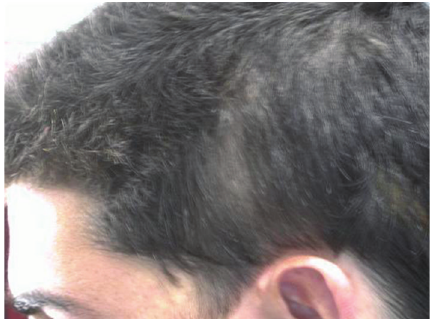
Figure 1: TTA, L. temple.